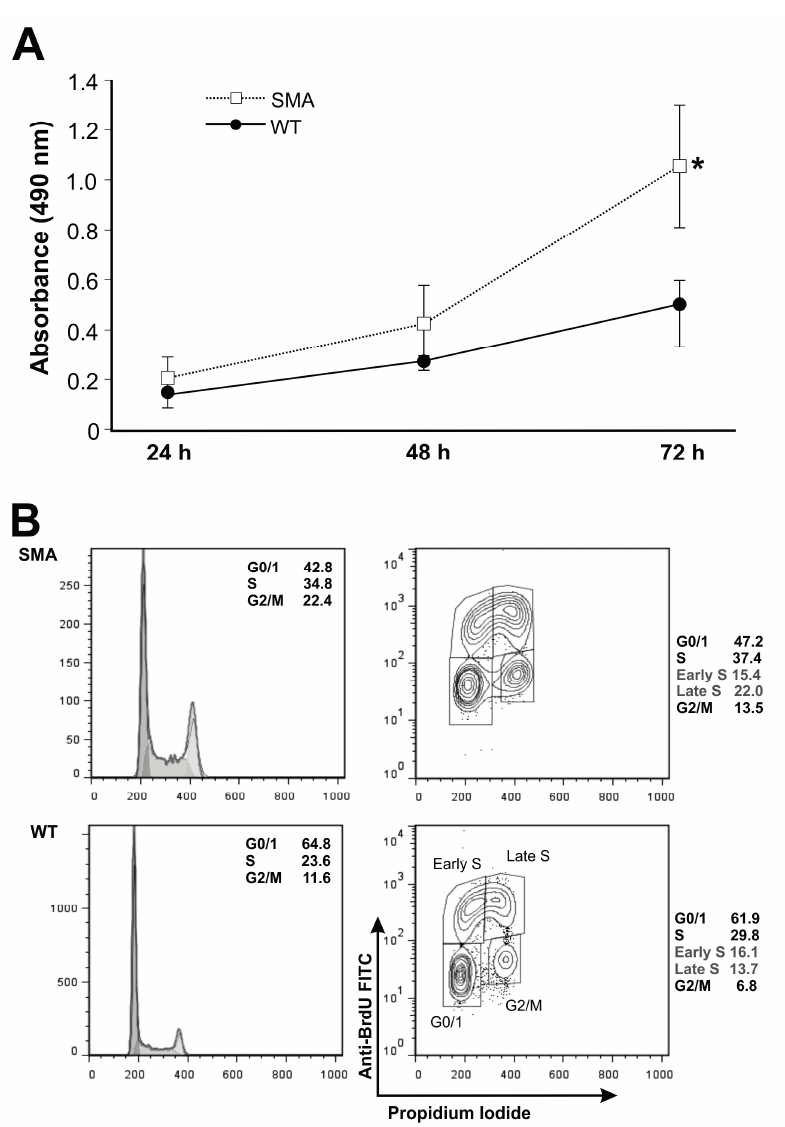
Figure 2. Viability and cell cycle analyses of NSCs from spinal cord. The graph shows the results of a viability (MTS) assay performed on NSCs derived from three animals per genotype, deriving from three distinct families. Each family contributed one wild type and one SMA mouse. Results are shown as the average ± the standard deviation and represent the average of two experiments performed independently. * p = 0.022 ( A ); Flow cytometry analysis of BrdU-positive cells of WT and SMA cells incubated with BrdU for 1 h. Representative histograms of cell cycle profiling only are shown on the left, reporting an insert with the relative percentage of cells in G0/G1, S and G2/M phases. On the right, histograms show the BrdU-positive cells, and an arbitrary gating strategy is used to identify cell fractions in early and late S phases. An insert in each panel reports the percentages of cells in the different phases of the cell cycle. Values in ( B ) are representative of one of three independent experiments, whereas the mean values and respective standard deviations are reported in Results